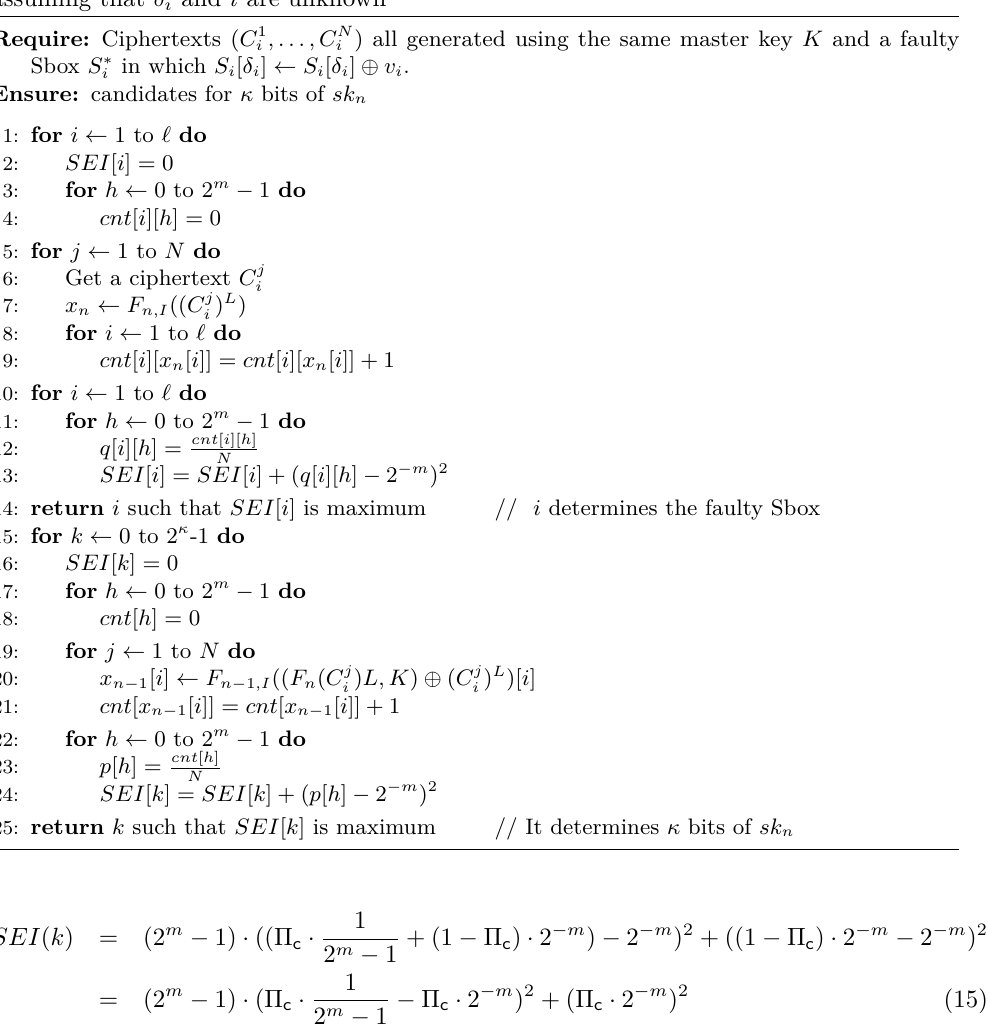
Algorithm 4 Key-recovery on a Feistel cipher with an infection-based countermeasure, assuming that δ and i are i